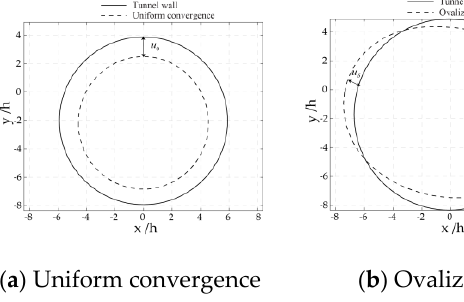
Figure 5. Basic displacement of the tunnel wall.